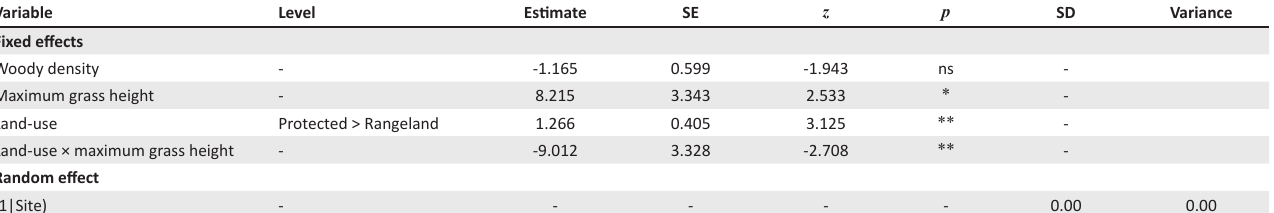
TABLE 1: Results from the best subset generalised linear mixed effects model assessing the effect of land-use types (protected areas versus communal rangelands) on raw avian species richness, while taking vegetation structure variables (maximum grass leaf table height and the density of woody vegetation > 0.5 m) into consideration. Variable